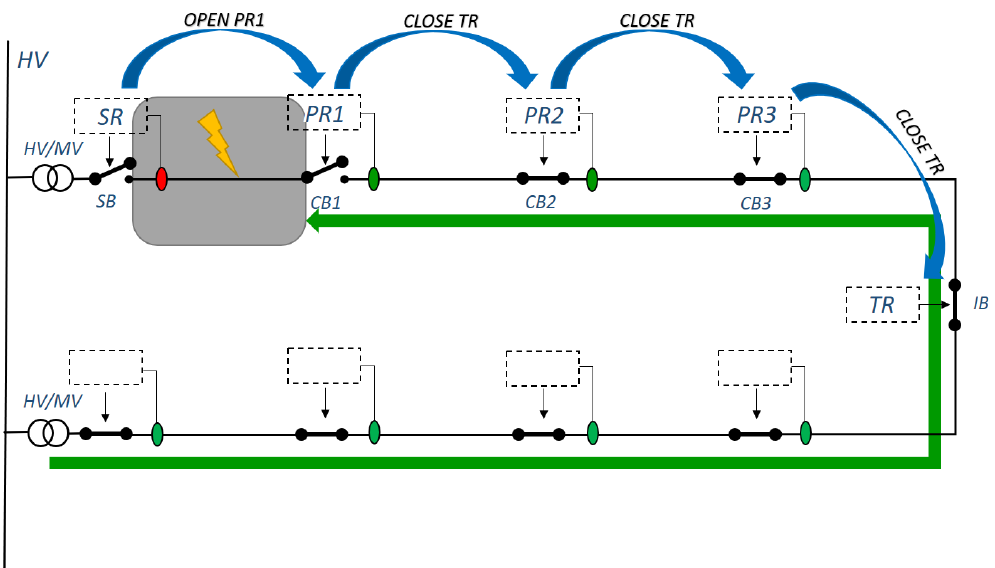
Figure 10. Message exchange between protections during the fault 50.S3 between SR and PR1.